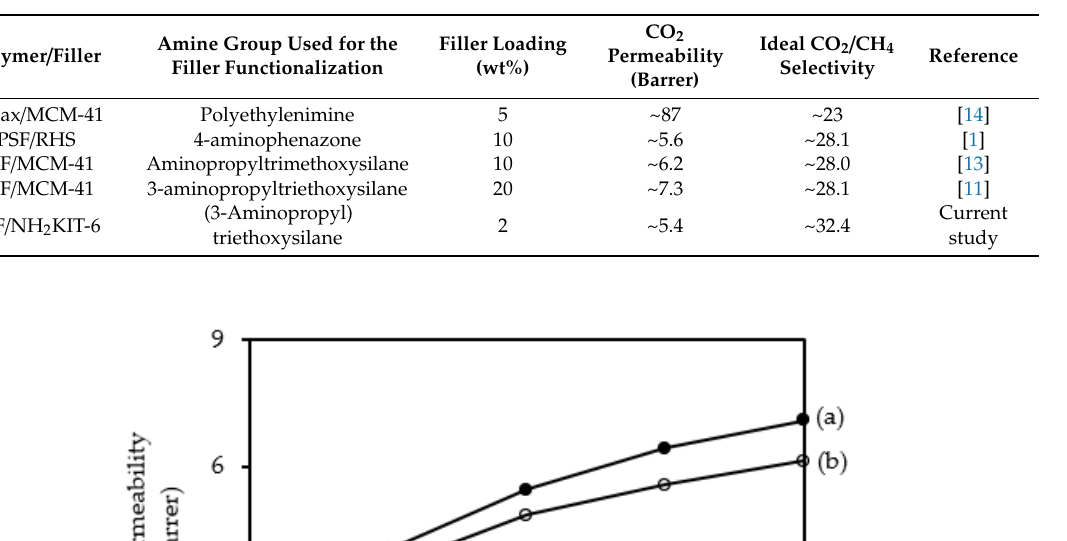
Table 1. Comparison of CO 2 permeability and ideal CO 2 / CH 4 selectivity between MMMs from current study and MMMs incorporated with functionalized silica reported in the literature.